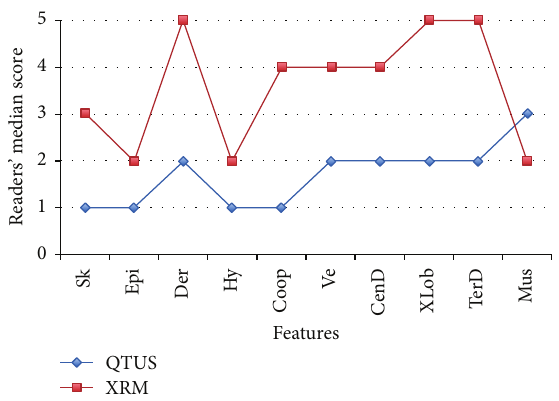
Figure 11: Readers’ median image quality score by modality (QT Ultrasound in blue and X-Ray Mammography or XRM in red) and breast feature: skin, epidermis, dermis, hypodermis, Cooper’s liga- ments, superficial veins, central ducts, extralobular ducts, terminal duct lobular units, and pectoralis muscle. 1 = excellent; 5 =